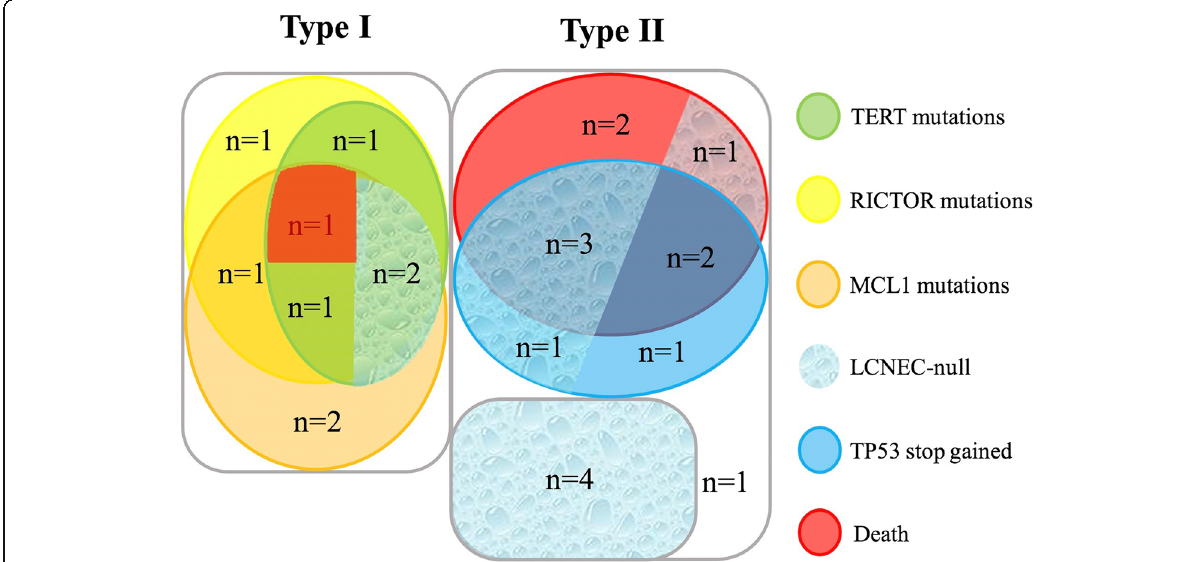
Fig. 4 Combined 11 LCNEC-nulls with 13 LCNECs, and then divided them into two different types based on RICTOR and MCL1 mutations. Genetic alterations were marked with circles of different colors, and 9 deceased cases was marked with red circle. Cases of LCNEC-null were filled with droplet